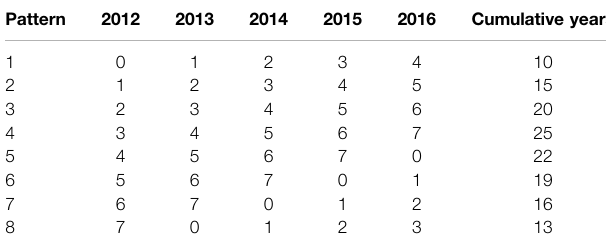
TABLE 1 | Trimming patterns and cumulative growth years.